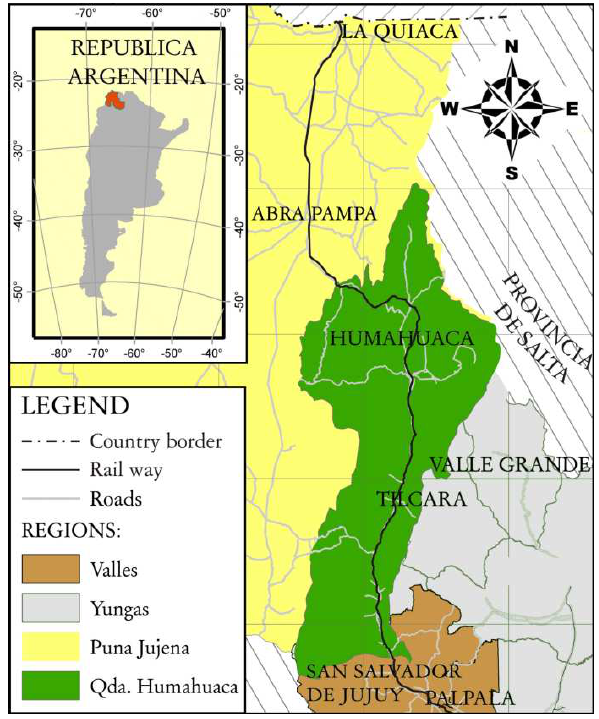
Fig. 1. Geographical setting. The Quebrada de Humahuaca region in the Province of Jujuy.